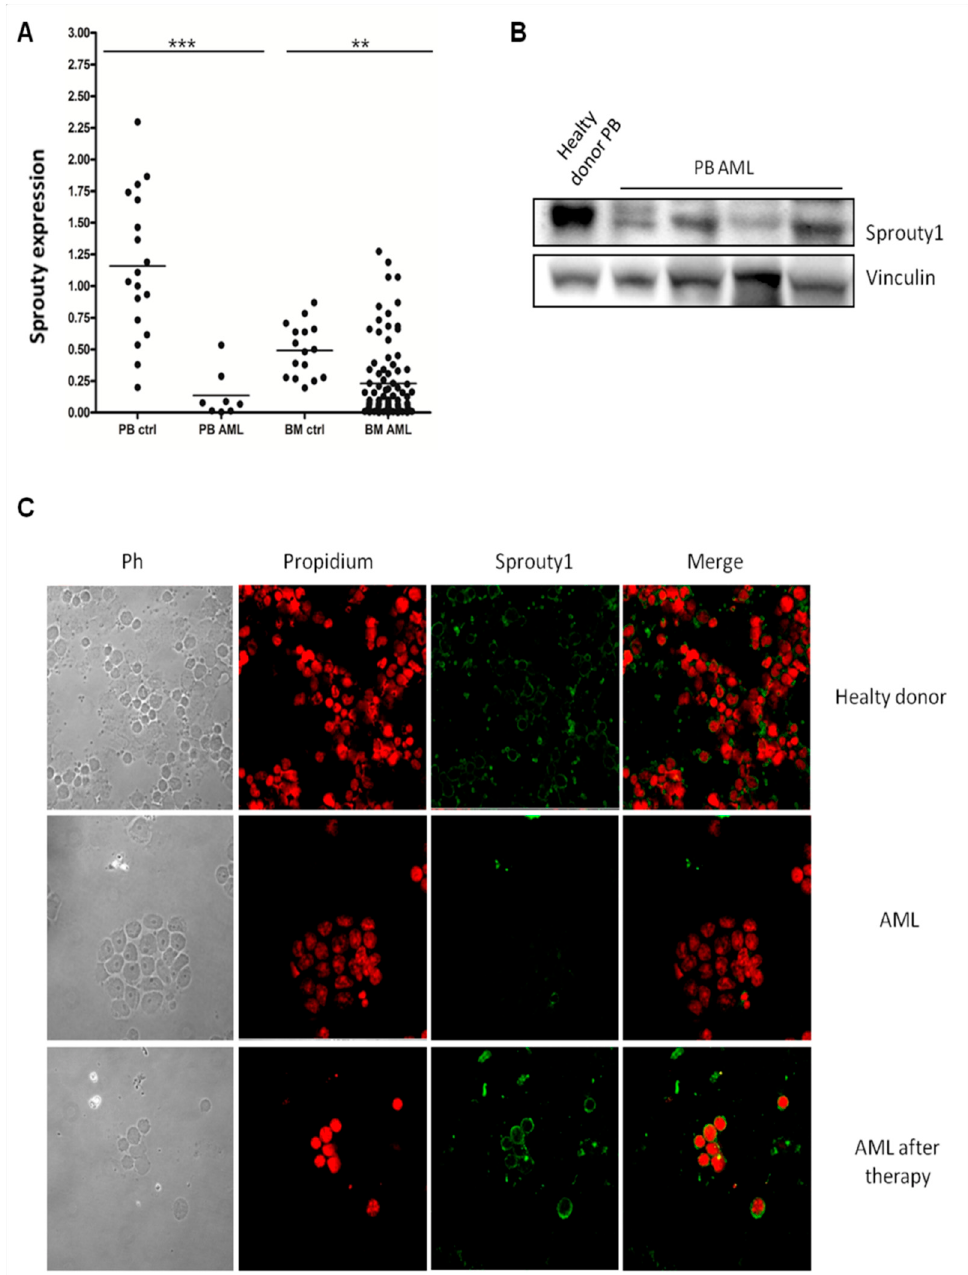
Figure 1. ( A ) Sprouty1 gene expression was assayed by qRT-PCR in BM and PB derived from both AML patients and normal subjects. The quantity is expressed as 2 −ΔΔ Ct after normalization with Abl housekeeping gene (** p ≤ 0.01 and *** p ≤ 0.001). ( B ) Western blot performed with anti Sprouty1 antibody on total protein derived from PB of four representative AML cells and one PB of a healthy donor. Vinculin is used as normalizer. ( C ) Immunofluorescence staining assay performed on cytospun BM cells of AML or control samples. The green signal corresponds to Sprouty1 while red propidium iodide is used to stain nuclei. BM, bone marrow; PB, peripheral blood; AML, acute myelocytic